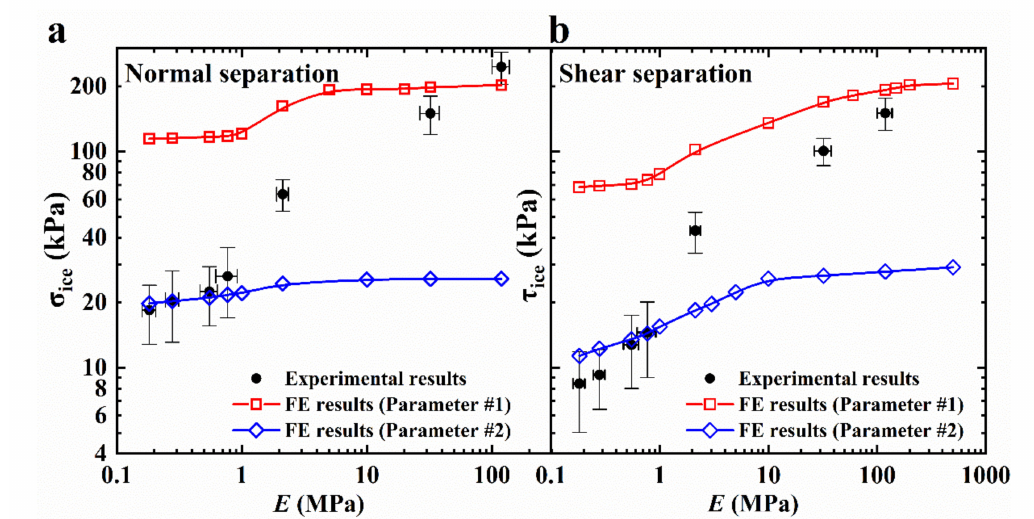
Figure 13. ( a ) σ ice and ( b ) τ ice vs. E for both experimental and FE simulation